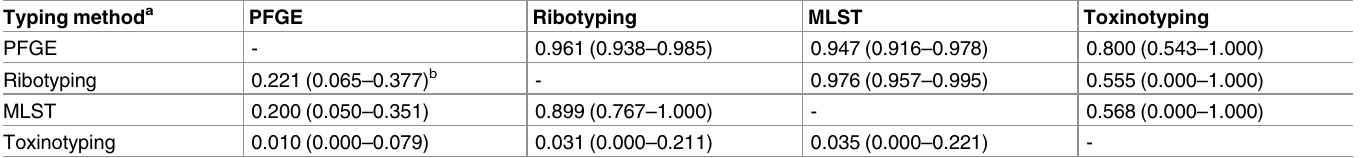
Table 3. Concordance values of four different typing methods estimated using the adjusted Wallace coefficient. Typing method a